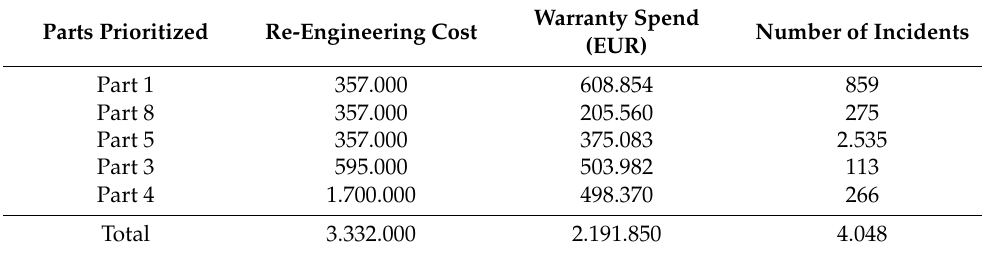
Table 13. Result (parts prioritized) and financial